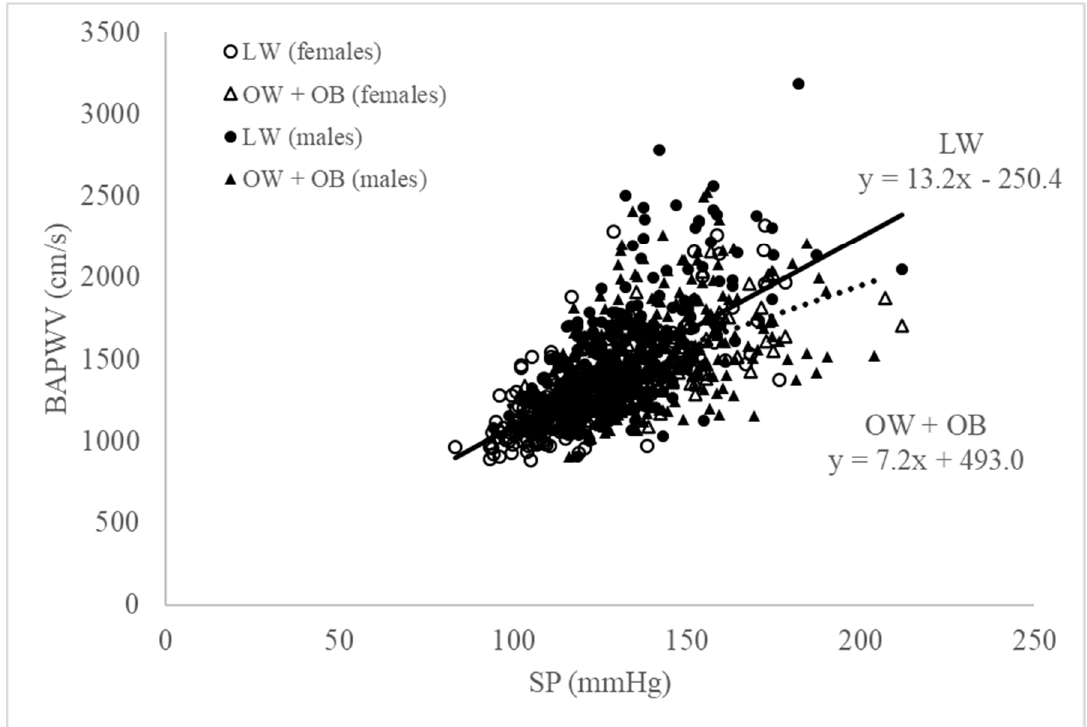
Figure 3. Relationship between brachial SP and BAPWV between normal-weight (LW = lean weight) (black open circles, females; black closed circles, males) and overweight (OW)/obese (OB) groups (black open triangles, females; black closed triangles, males). A linear relationship (solid line for LW, dashed line for OW + OB) between BMI class and BAPWV was only apparent for males aged ≤ 50 years ( p = 0.01) and females aged >50 years ( p < 0.01). The increase in arterial stiffness (measured as baPWV) in the normal group appeared to be greater with similar brachial SP values when these subjects were compared to individuals in the overweight and obese groups.